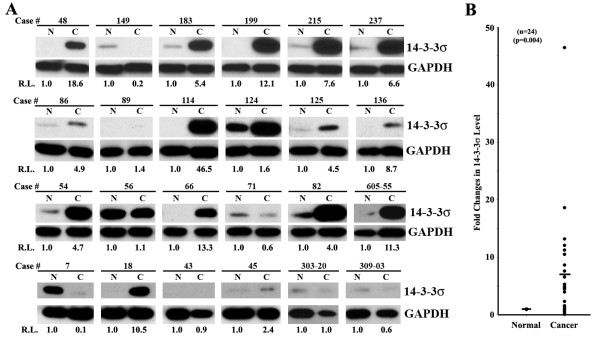
14-3-3σ expression in paired normal and cancer pancreas. A, Western blot analysis. Lysates from fresh frozen matching human normal (N) and pancreatic ductal adenocarcinoma (C) tissues were separated by SDS-PAGE followed by Western blot analysis of 14-3-3σ and GAPDH control. The relative level (R.L.) of 14-3-3σ in each sample was measured and normalized to that of GAPDH. The level of 14-3-3σ in each normal tissue was set to 1. B, summary of Western blot analysis. The relative levels of 14-3-3σ in normal and cancer tissues were graphed with the median level in each group marked by (-). Statistical analysis was done using Student T-test.